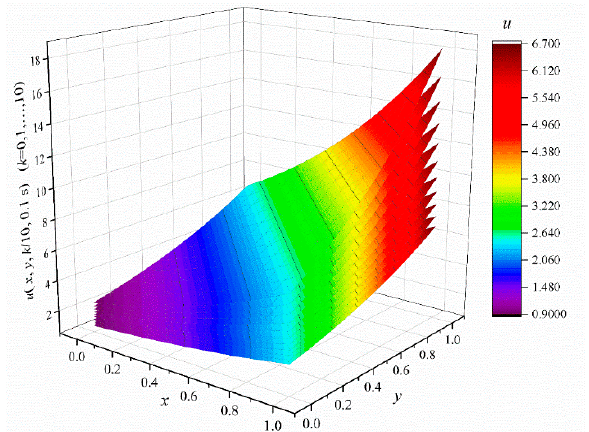
is different. Figure 7. Calculation results along z -axis when t 0 is different. is different. 0 0